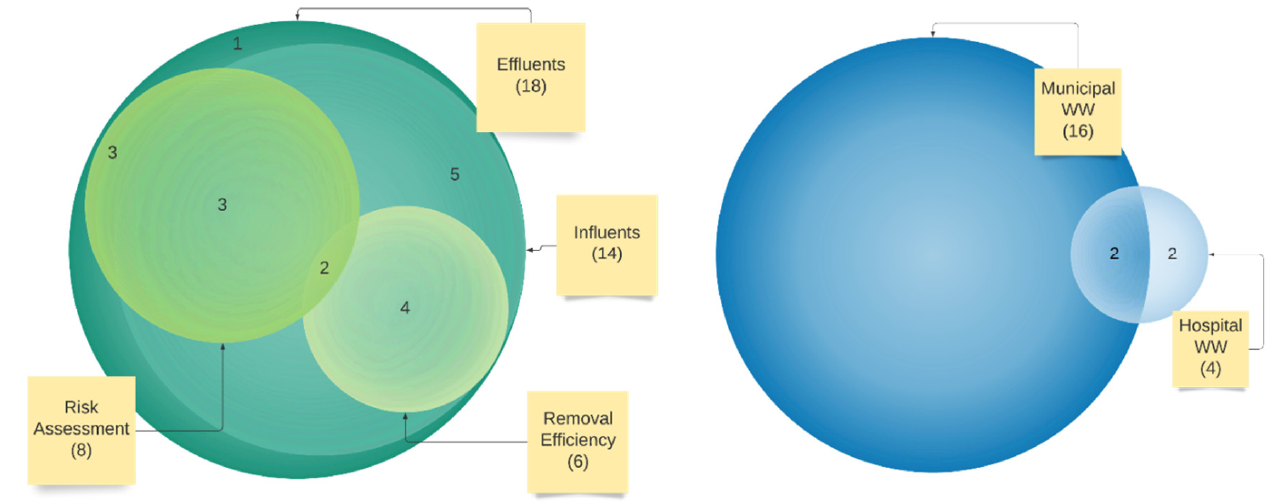
Figure 2. Subject areas of the 18 studies that were scrutinised in the data extraction phase. (Source: Lucidchart).